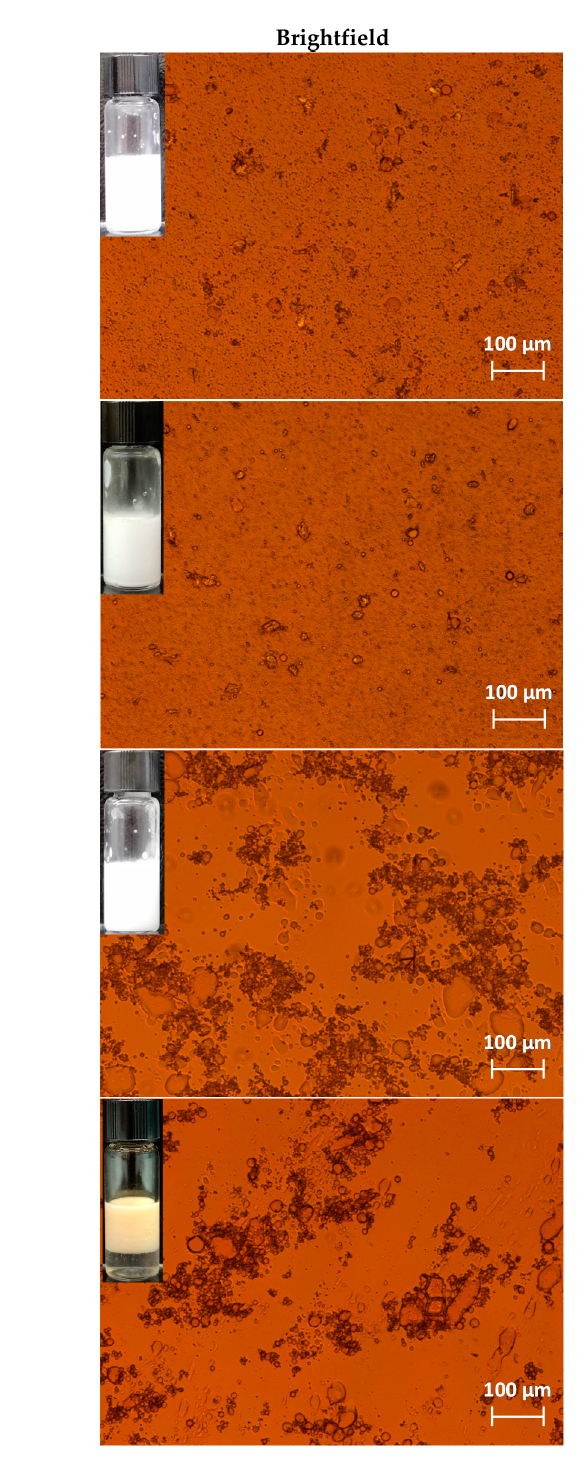
Figure 4. Comparison between brightfield (left column) and fluorescence (right column) micrographs of emulsion stabilized with ( a ) BM30-CP, ( b ) BM60-CP, ( c ) HPH-NC, and ( d ) HPH-TP.